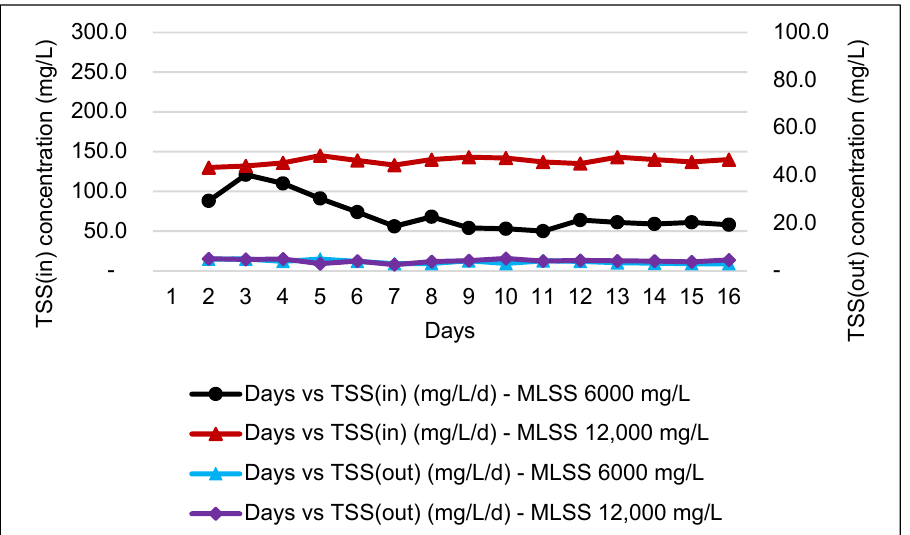
Figure 5. Graph of TSS influent and effluent for an MBR system at MLSS values of 6000 mg/L and 12,000 mg/L by using an HF membrane.